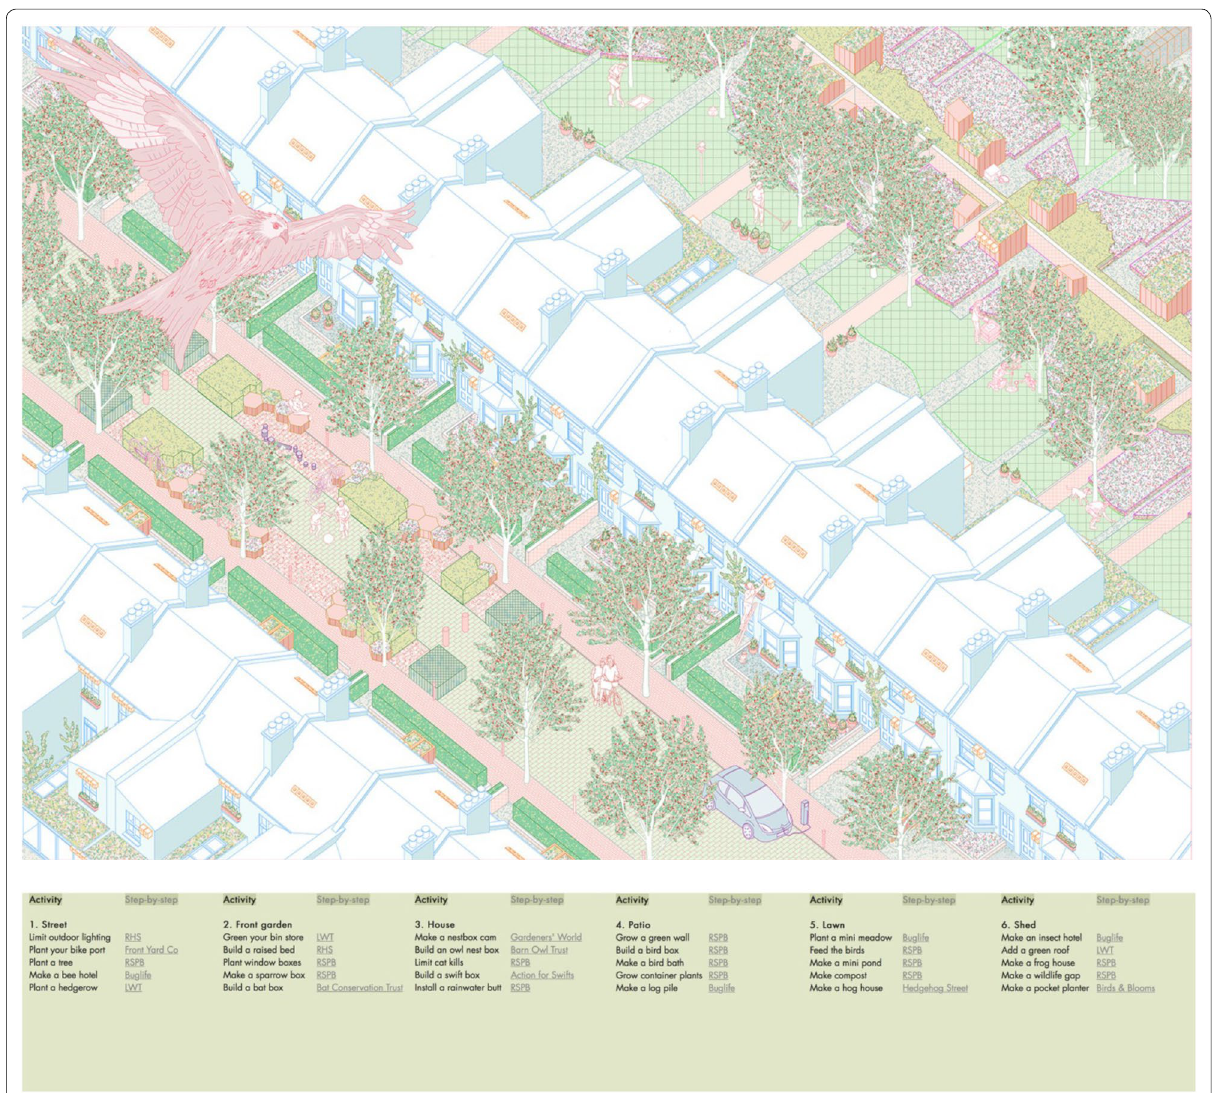
Fig. 5 Aerial view showing proposed typical street with adaptations for biodiversity, focusing on activities (Viktoria